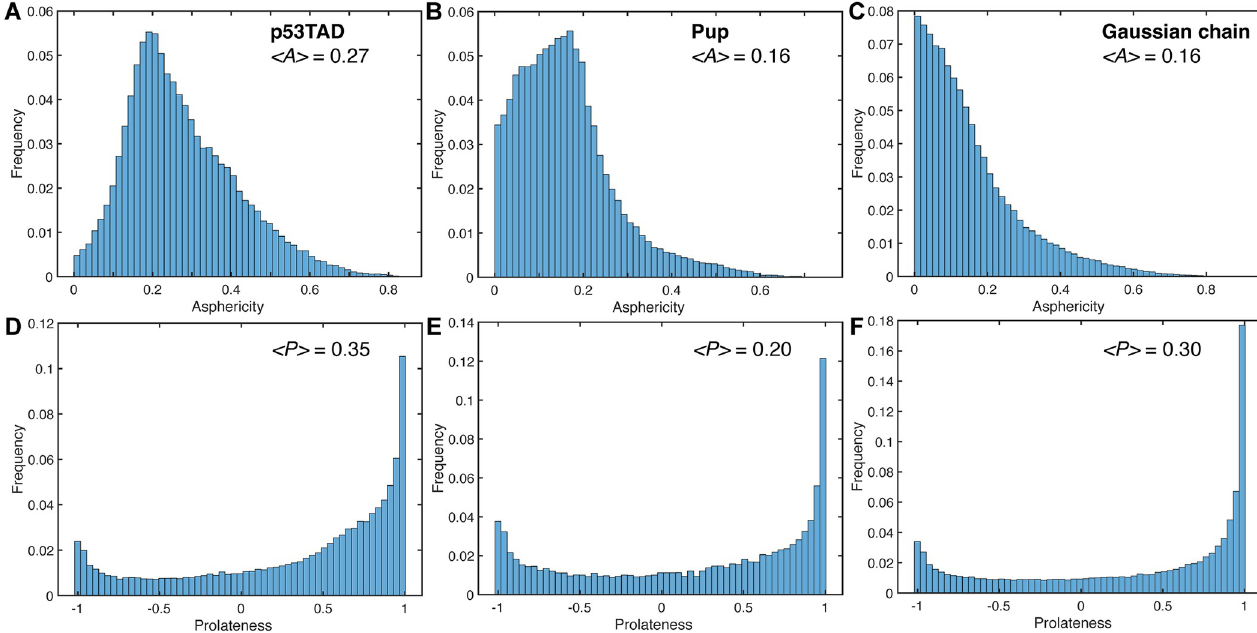
Fig 2. Gyration tensor properties of IDP ensembles of p53TAD and Pup across 10 1- μ s MD trajectories. The distributions of gyration tensor asphericities A are shown for (A) p53TAD and (B) Pup in comparison with a (C) Gaussian chain. The distributions of gyration tensor prolateness P are shown for (D) p53TAD and (E) Pup in comparison with a (F) Gaussian